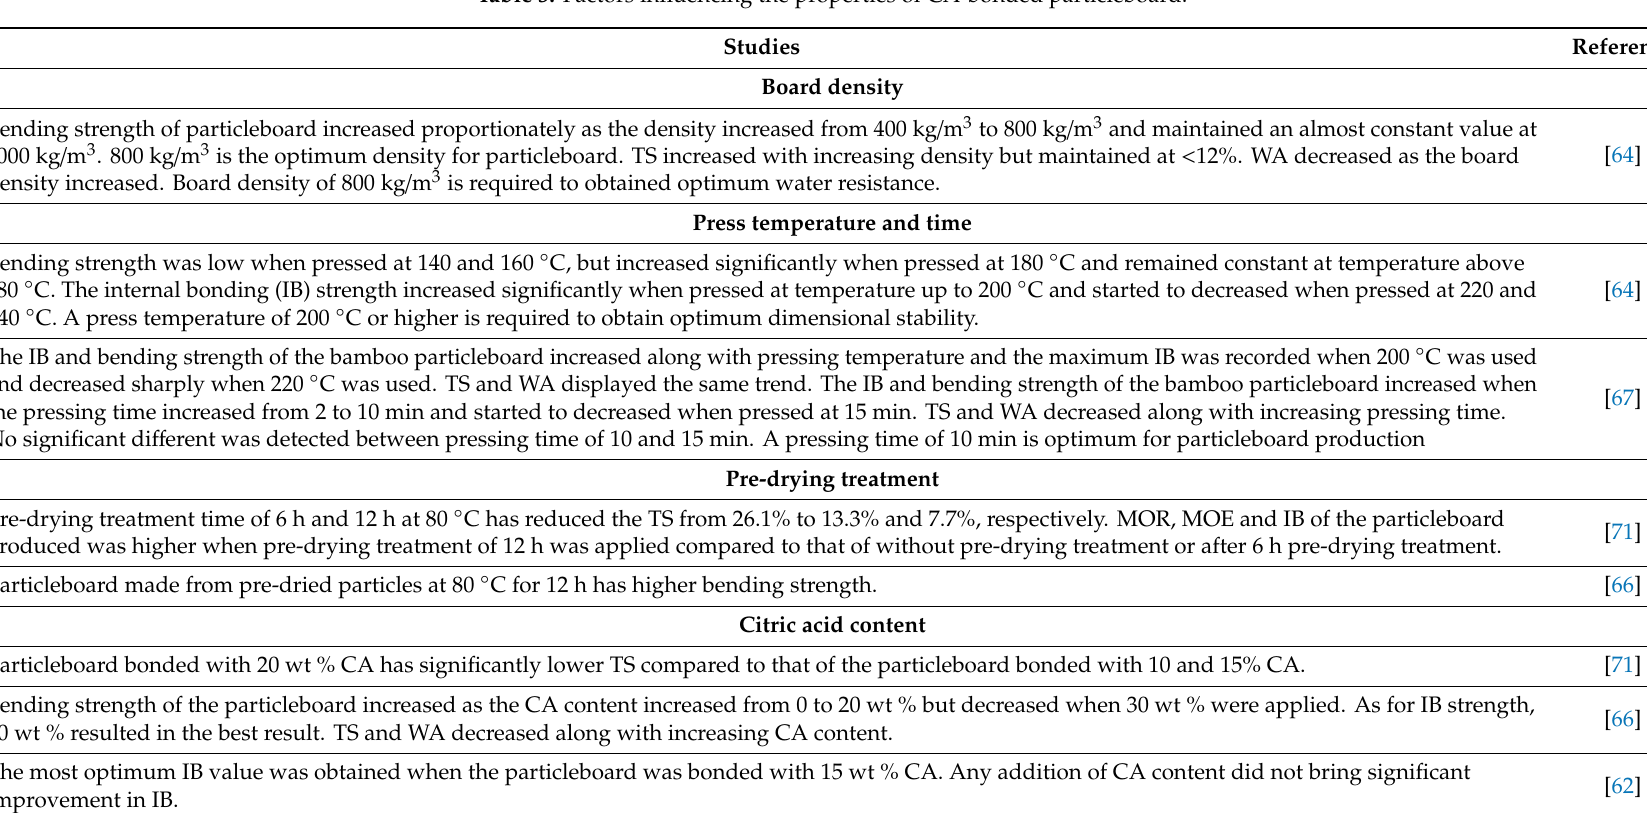
Table 3. Factors influencing the properties of CA-bonded